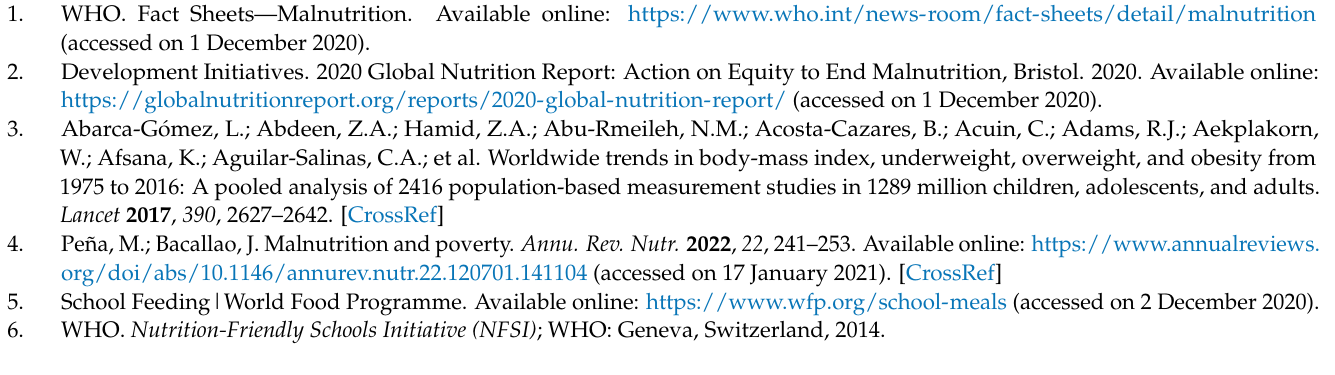
studies, Figure S8: Sensitivity analysis: removing quasi-experimental studies, Table S1: Characteristics of studies included in this review, Table S2: Intervention